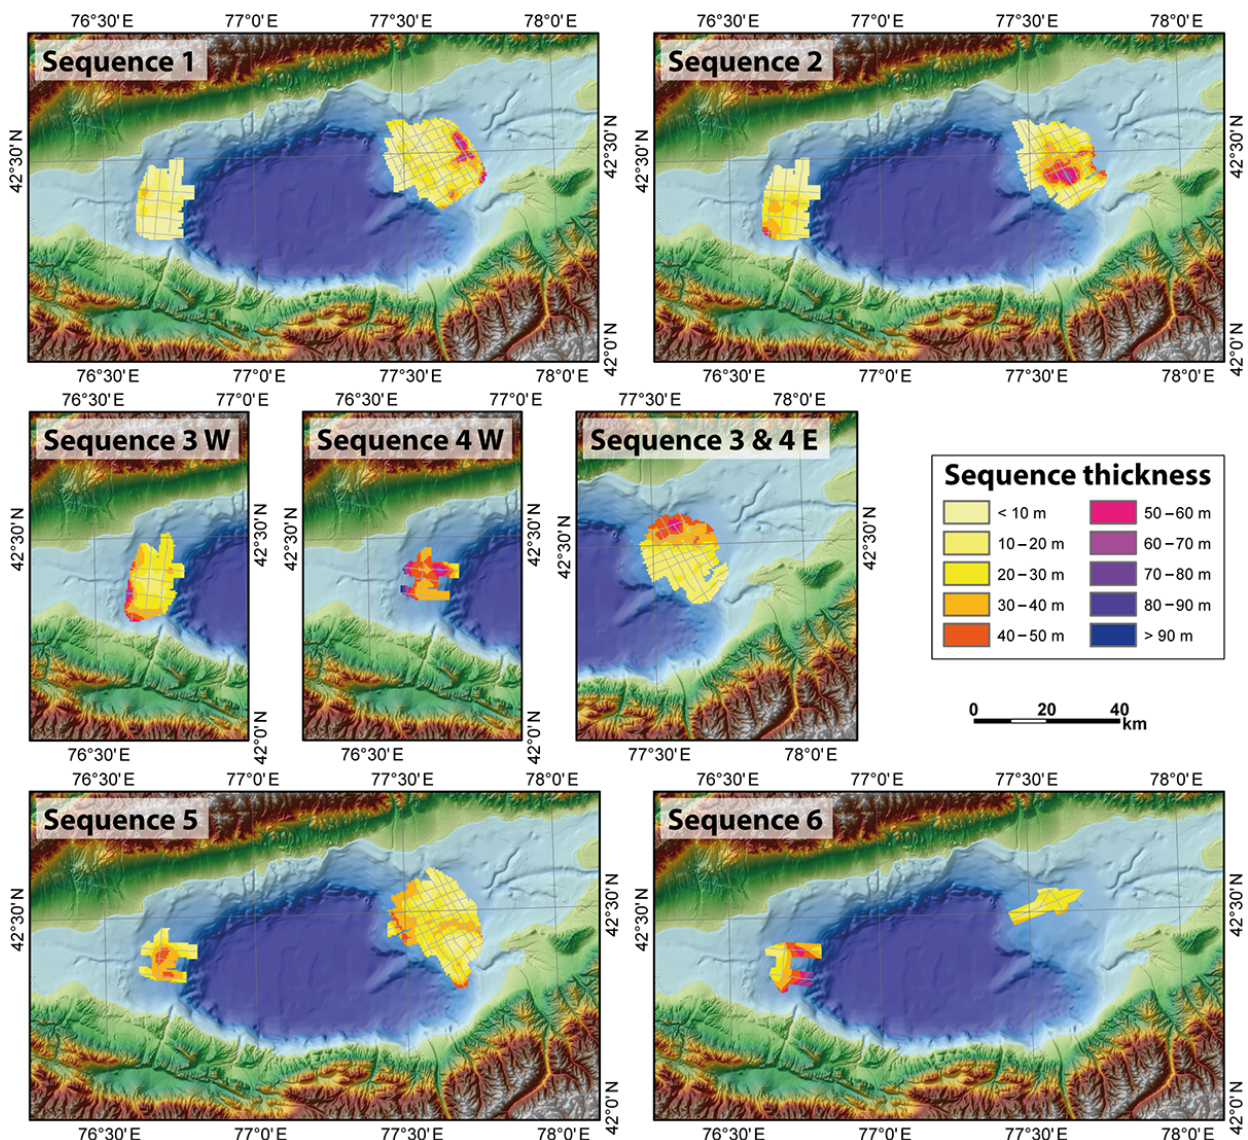
Figure 7. Minimum thickness of sequences in the western and eastern areas. Thickness is converted from two-way travel time using a seismic velocity of 1500ms − 1 . Thickness color scale is similar for all panels and shown in the figure. Color scales for topography and bathymetry are similar to Fig. 1. Grey lines show where data were available for thickness calculation. Note that sequences 3 and 4 could only be distinguished in the western delta, while a combined thickness for sequences 3 & 4 was calculated for the eastern